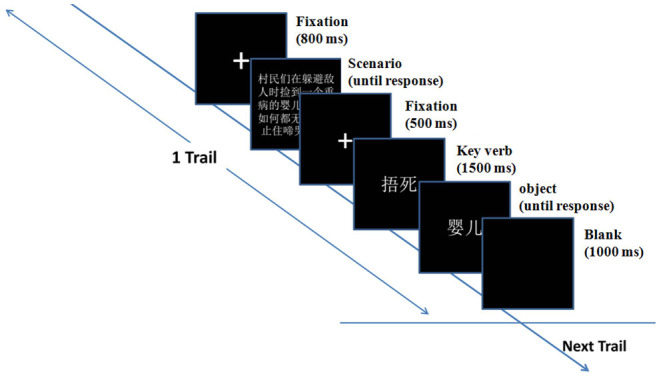
The sequence of events in a single trial.